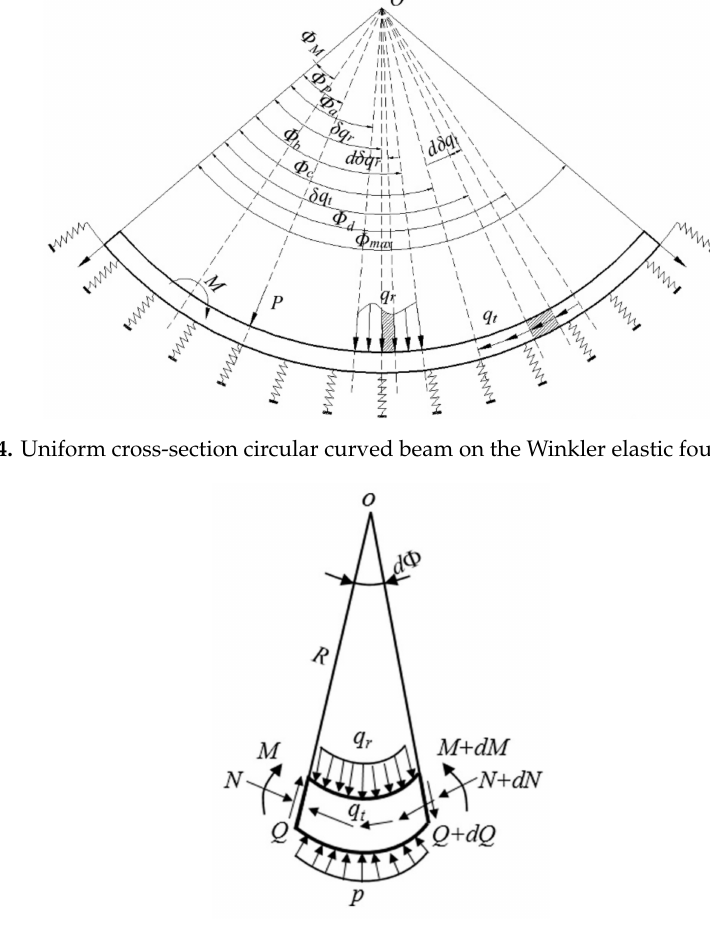
Figure 5. Diagram of force analysis on the microelement body